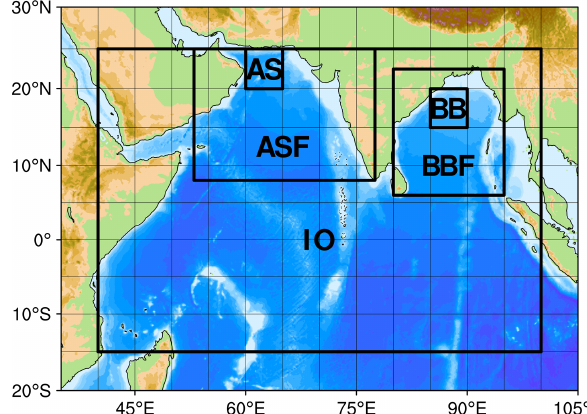
Figure 5. Regions over which spatial average is computed for the vertical profiles of fields (temperature, salinity and nutrients). Acronyms as used for further analysis: IO – Indian Ocean, ASF – Arabian Sea full, AS – Arabian Sea box, BBF – Bay of Bengal full, BB – Bay of Bengal